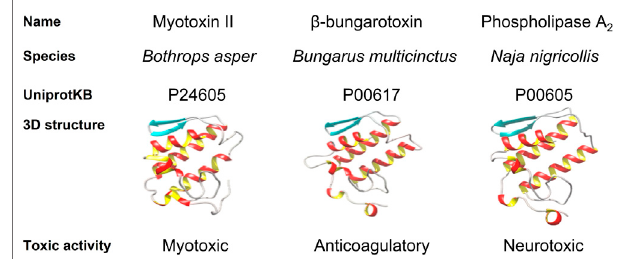
FIGURE 1 | Comparison of Myotoxin II from Bothrops asper , β - bungarotoxinfrom Bungarusmulticinctus andaphospholipaseA 2 (PLA 2 )from Naja nigricollis . They are homologous proteins that cluster together due to sequence similarity and share an archetypical PLA 2 fold. Nevertheless, they differ in their toxic activity.